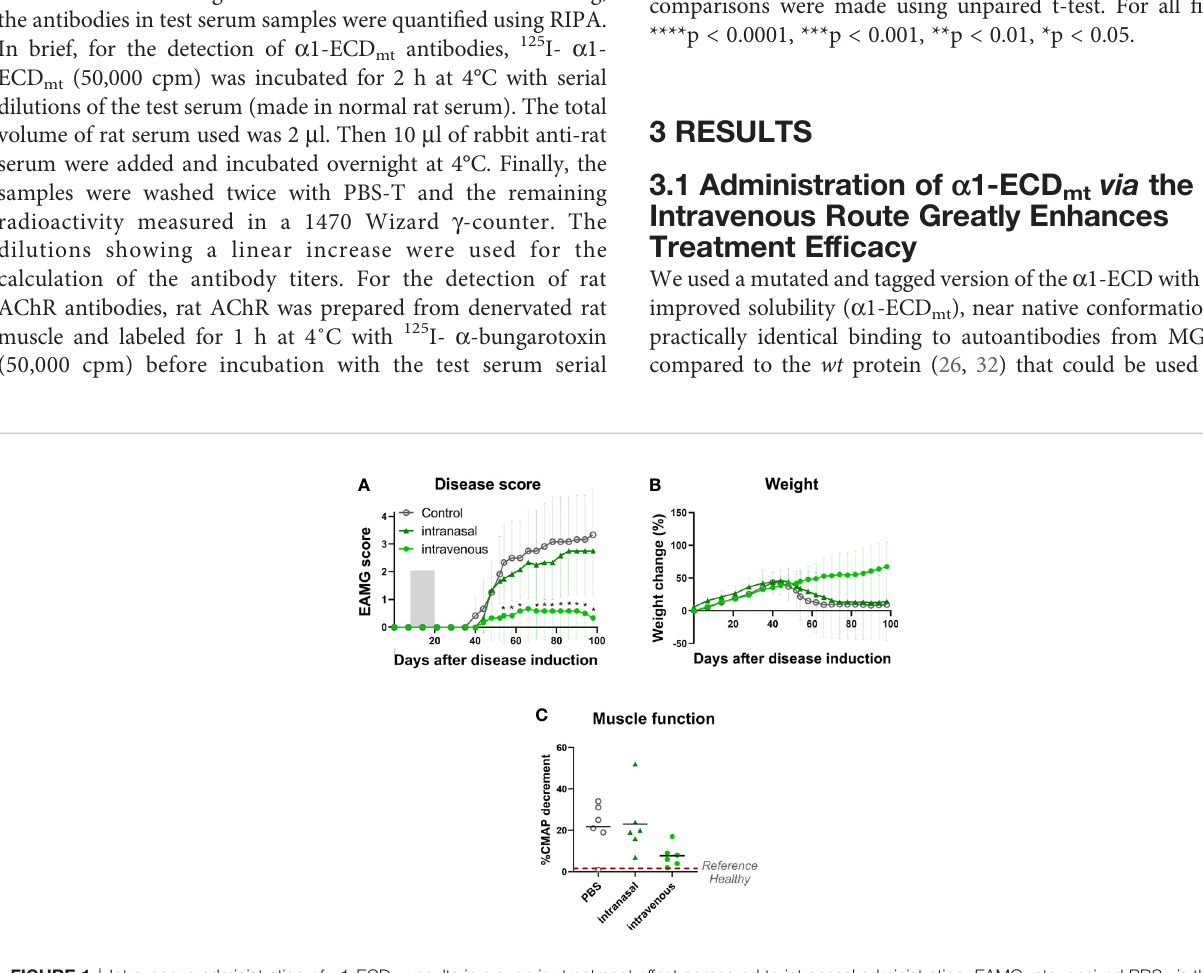
FIGURE 1 | Intravenous administration of a 1-ECD mt results in a superior treatment effect compared to intranasal administration. EAMG rats received PBS via the intravenous route (N = 6, empty circles) or 100 m g a 1-ECD mt in PBS via the intranasal (N = 6, triangles) or the intravenous route (N = 6, fi lled circles) on twelve consecutive days, from day 7 to day 18 of the experiment. (A) Average EAMG score (± SD) for each group; the grey bar indicates the treatment period. (B) Average percentage of body weight change (± SD). (C) CMAP decrement: each symbol corresponds to one rat and the bar shows the mean value. * Compares intravenous a 1-ECD mt and